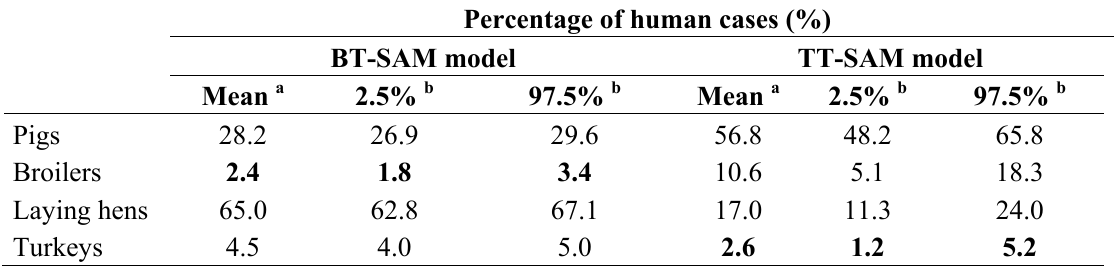
Table 3. Percentage (%) of human salmonellosis cases in EU attributable to the four main animal reservoirs included in the BT-SAM [7,15] and TT-SAM model